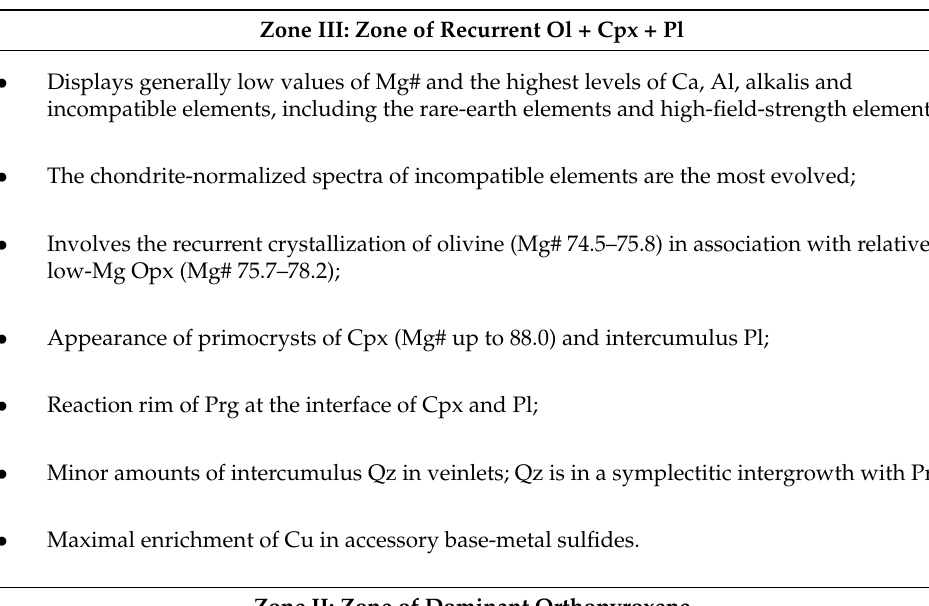
Table 1. Major structural units of the Lyavaraka ultrabasic